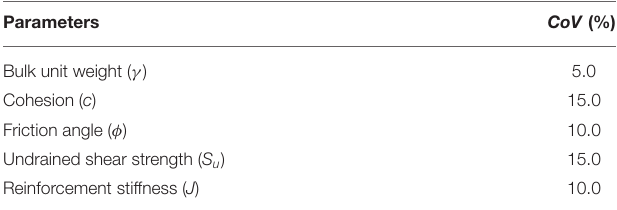
TABLE 6 | Parameters and CoV assumed by Chowdhury and Tang (1987).